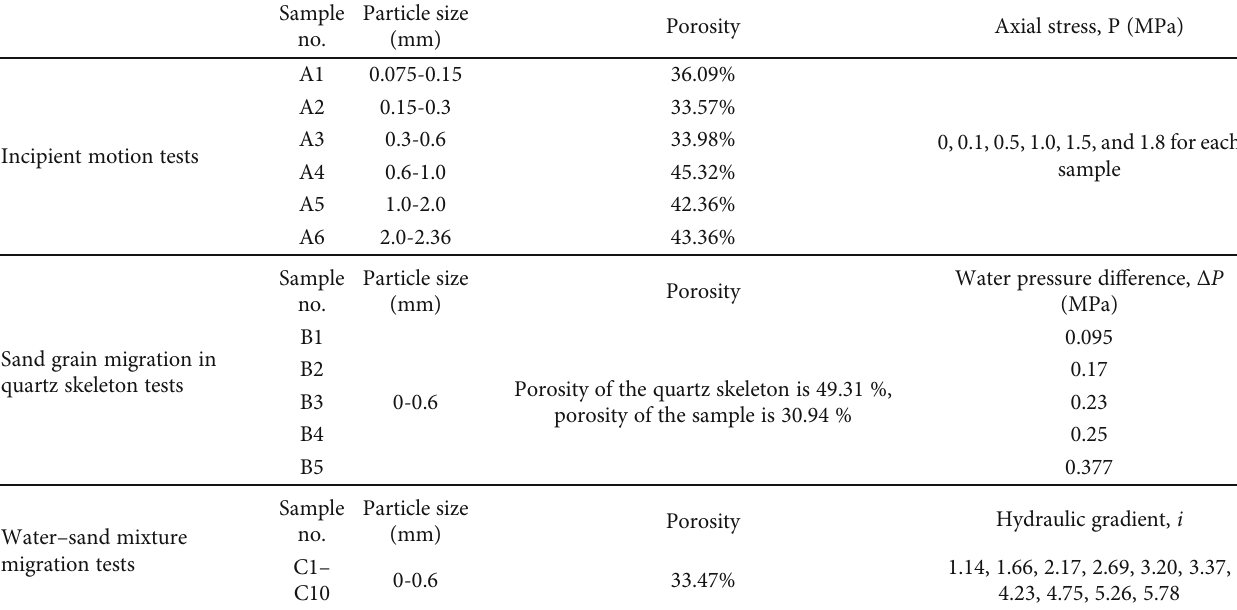
Table 1: Details of the testing samples.